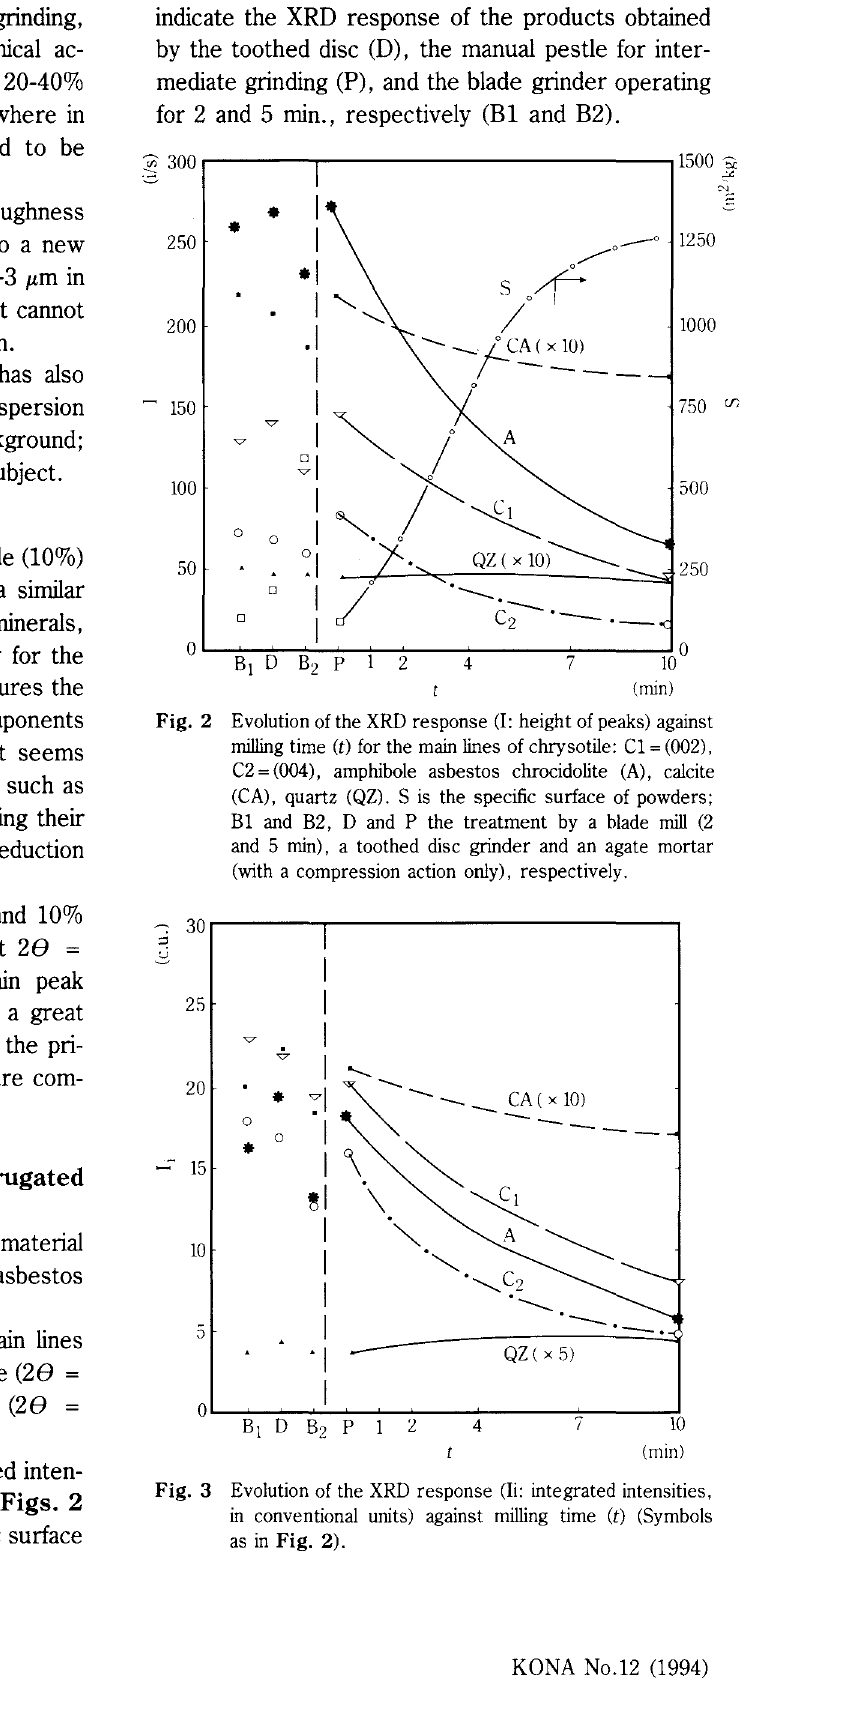
Fig. 3 Evolution of the XRD response (Ii: integrated intensities, in conventional units) against milling time (t) (Symbols as in Fig.